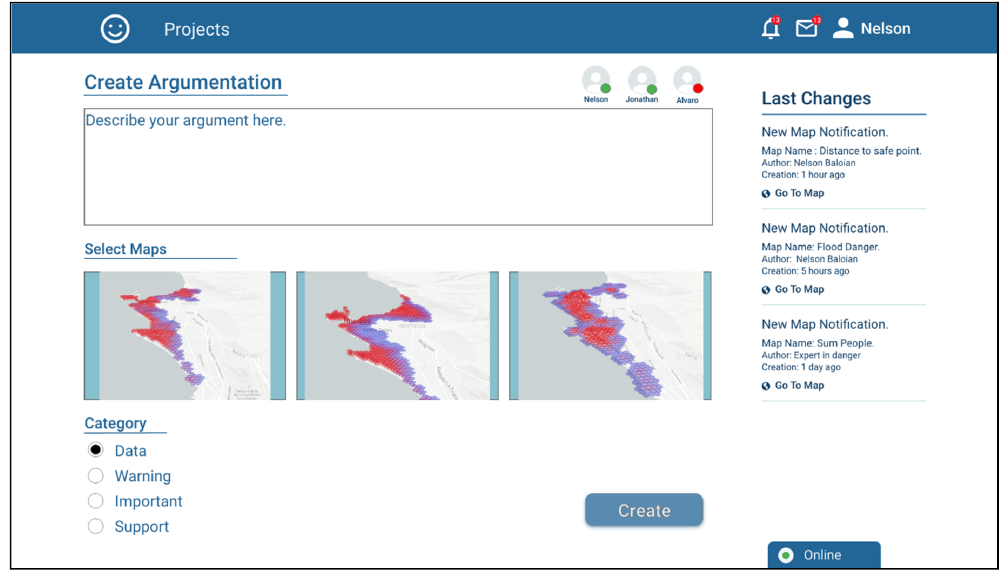
Figure 10. Creation of an Argumentation Object of the Data category.